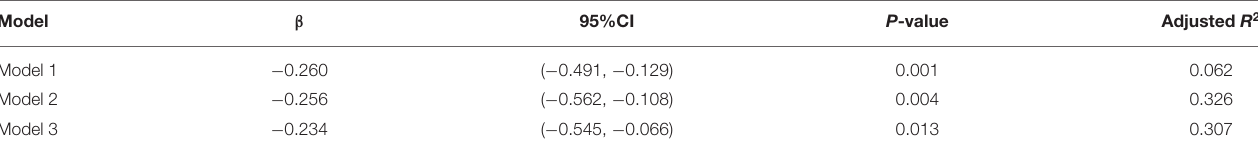
TABLE 2 | Linear regression analyses between BHB and TAC severities. Model β 95%CI P